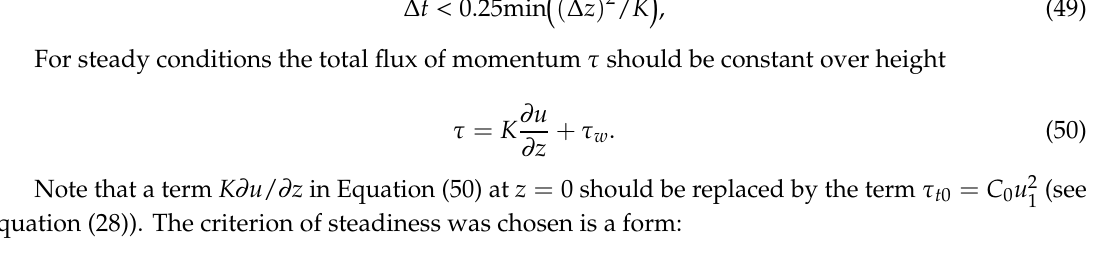
τ k of WPMF (Wave Produced w